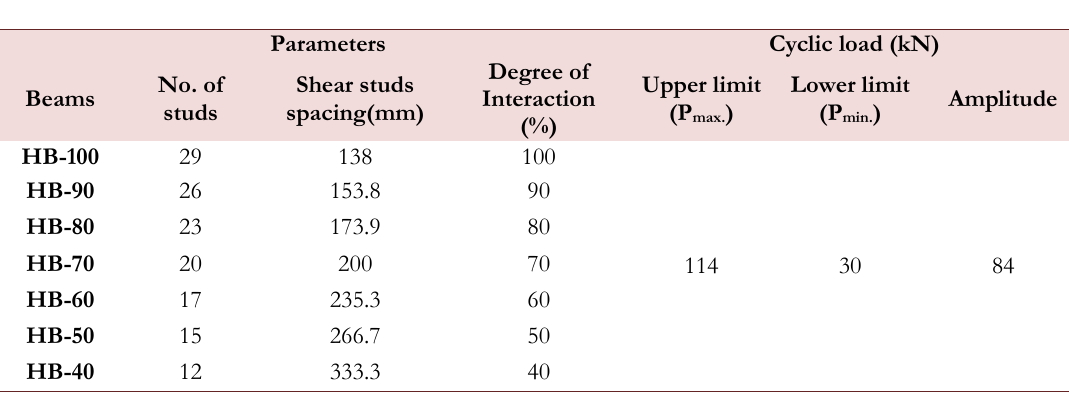
Table 1: Used models and analyzed parameters in this